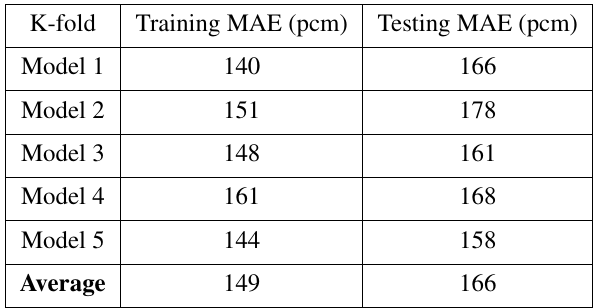
Table 2: Training and validation results of the DNN performance based on